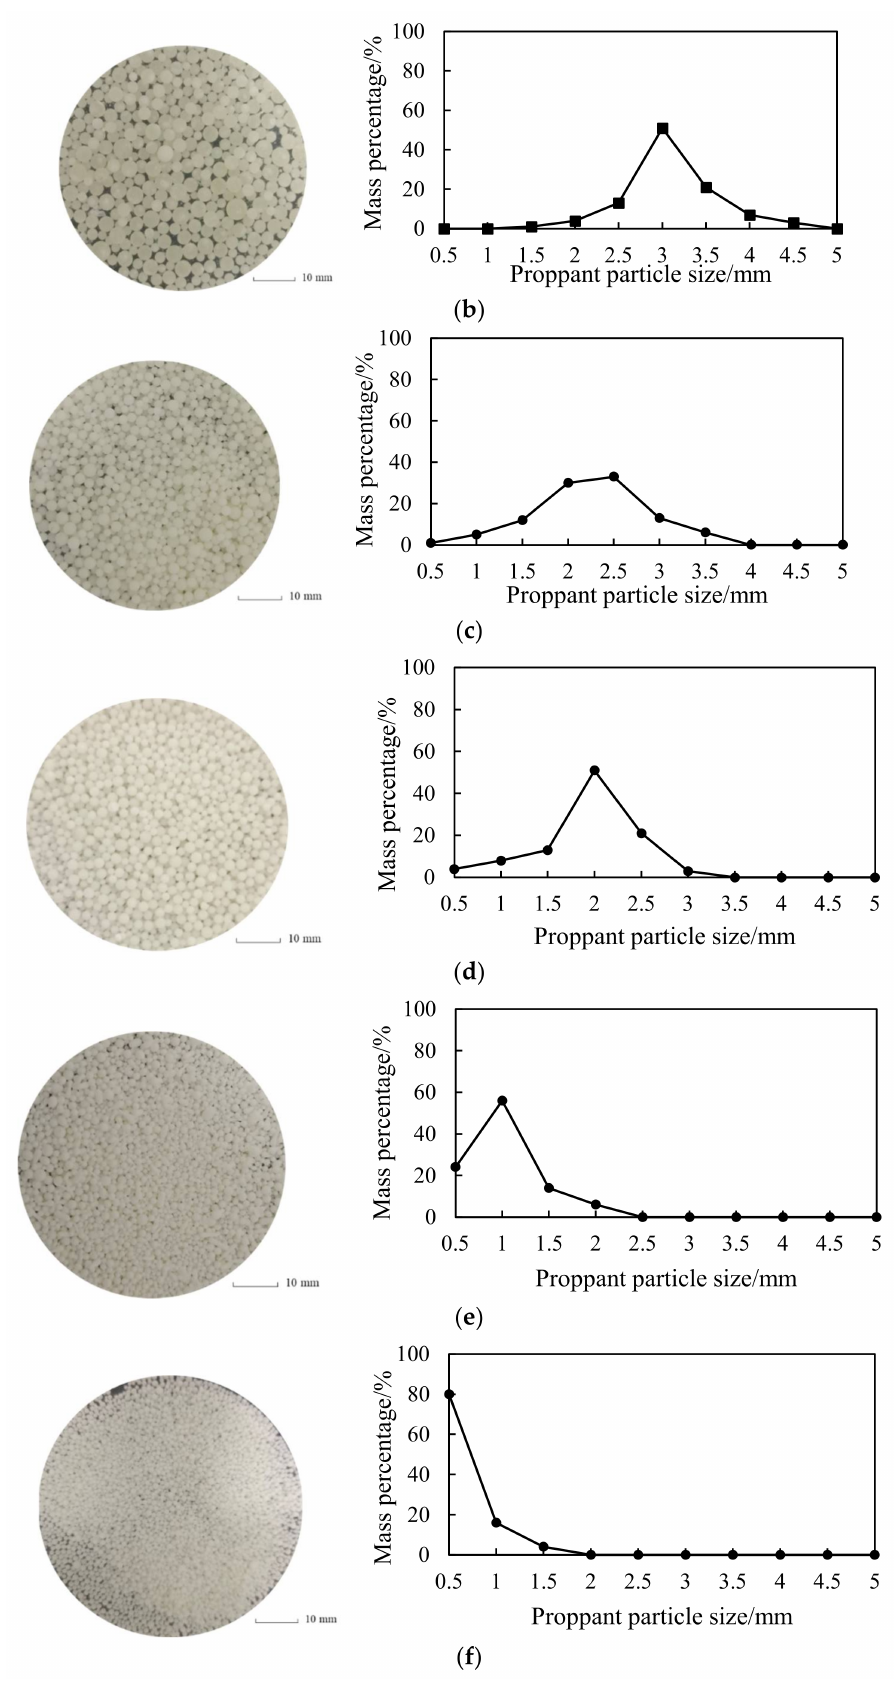
Figure 7. Proppant morphology and particle size distribution at different stirring speeds. (( a – f ) are proppants obtained at stirring speeds of 150, 200, 250, 300, 350 and 400 rpm,